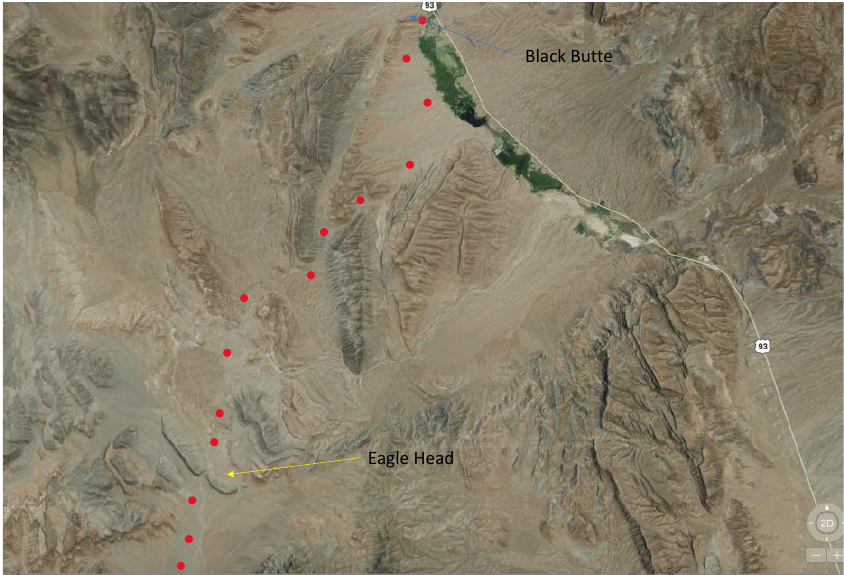
Figure 13. Trail from Black Butte to Eagle Head (Source: Google Earth).